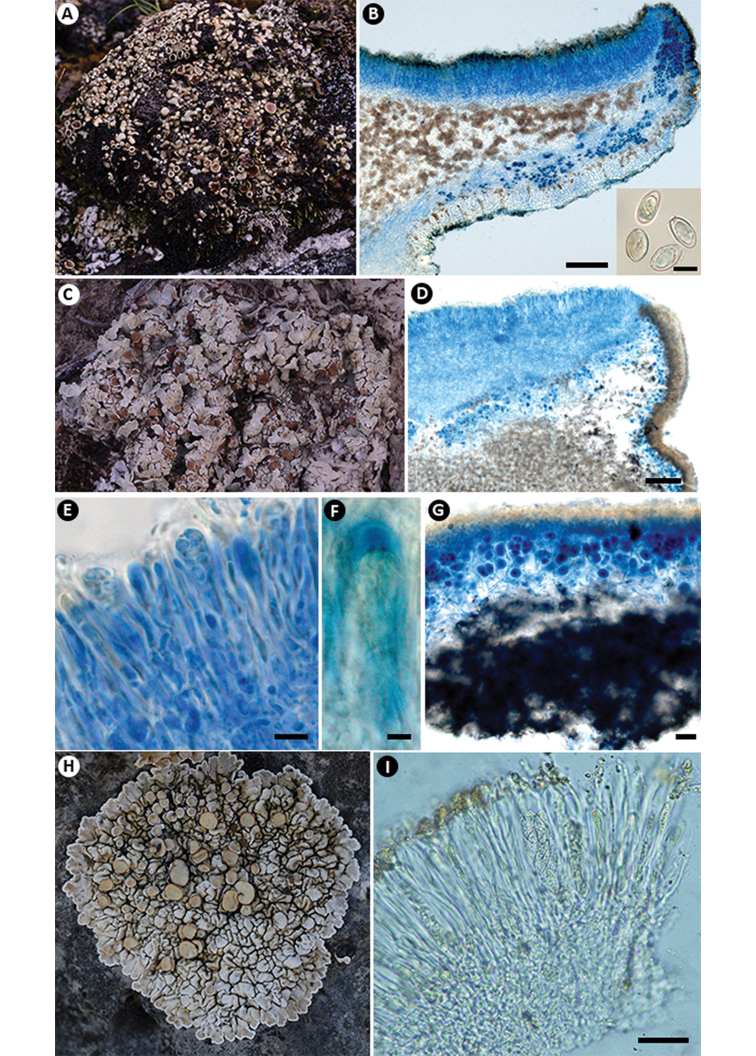
Lecanora
chondroderma (A, BKUN-L 18-60317): A habit B apothecial anatomy (LCB) and ascospores (water). Squamarina
kansuensis (C–GKUN-L 18-59601): C habit D apothecial anatomy (LCB) E ascus and ascospores (LCB) F apical structure of ascus (Lugol’s) G section of thallus (LCB). S.
oleosa (H, IKUN-L 09−30043): H habit I ascus and ascospores (water). Scale bars: 100 μm (B-apothecia, D); 5 μm (B-ascospores, F); 10 μm (E); 20 μm (G); 25 μm (I).